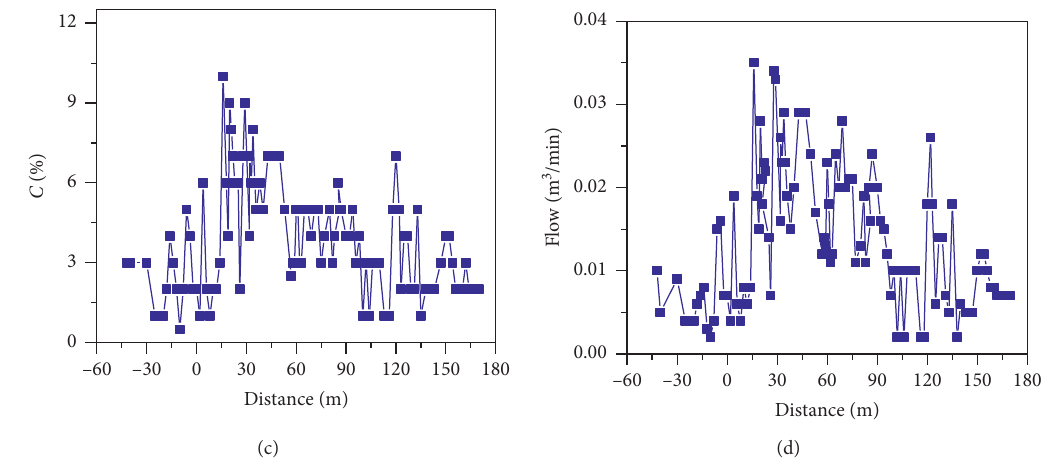
Figure 11: Gas monitoring data in no. 1 borehole of group